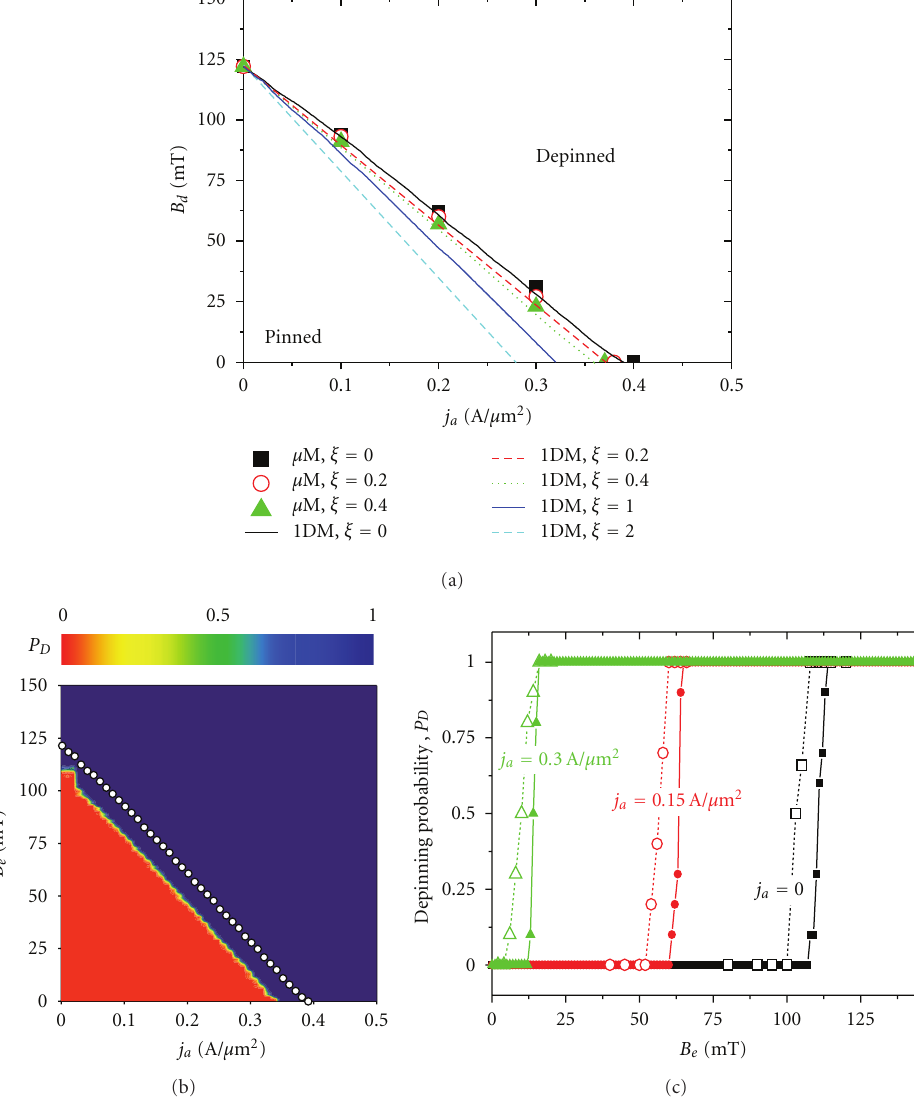
Figure 8: (a) Depinnig field B d as a function of j a for several values of ξ for a CoPtCr strip with L y × L z = 60nm × 3nm and n x = 15nm and n y = 6nm. Dots correspond to μM results and lines correspond to the ones obtained from the 1DM with Δ = 8 . 25nm, H K = 2626 . 06A / m, and a pinning potential given by V pin ( X ) = (1 / 2) K N X 2 for | X | ≤ L N with K N = 1 . 7 × 10 − 3 N / m and L N = 9 . 5nm ( V pin ( X ) = 0 for | X | ≥ L N ). (b) Probability of DW depinning ( P D ) as a function of both ( B e , j a ) obtained from 1DM with ξ = 0 at T = 300K. A temporal window of t w = 500ns was considered, and 100 stochastic realizations were evaluated. Open dots represent the deterministic ( T = 0) depinning field B d ( j a ). (c) Examples of P D as a function of B e under three di ff erent density currents: j a = 0 (squares), j a = 0 . 15A /μ m 2 (circles) and j a = 0 . 3A /μ m 2 (triangles). Filled and open symbols correspond to 1DM and μM results respectively (Reprinted with permission From [65]. Copyright (2012), American Institute of